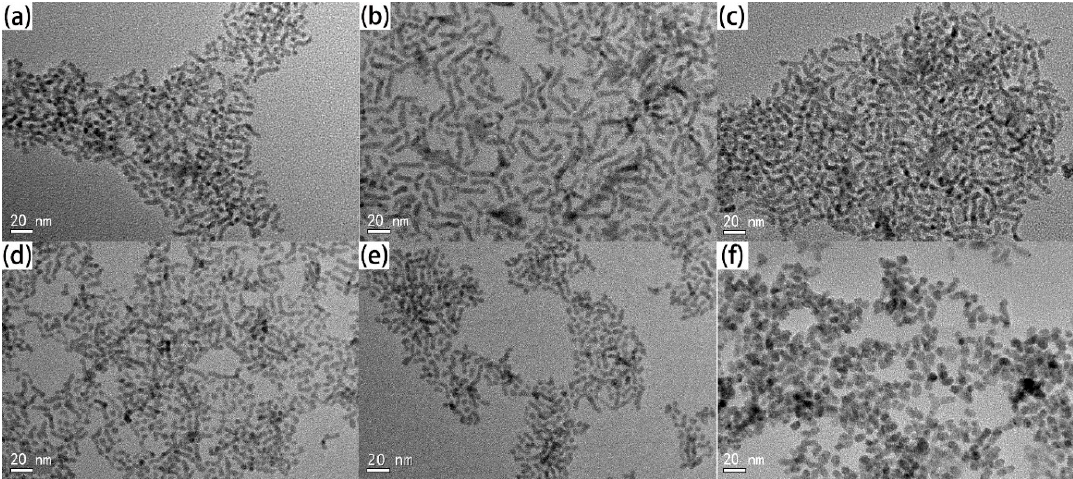
Figure 1. TEM images of CdSe x Te 1 − x alloy NCs with different composition: ( a ) x = 0, ( b ) x = 0.1, ( c ) x = 0.2, ( d ) x = 0.4, ( e ) x = 0.6 and ( f ) x = 0.